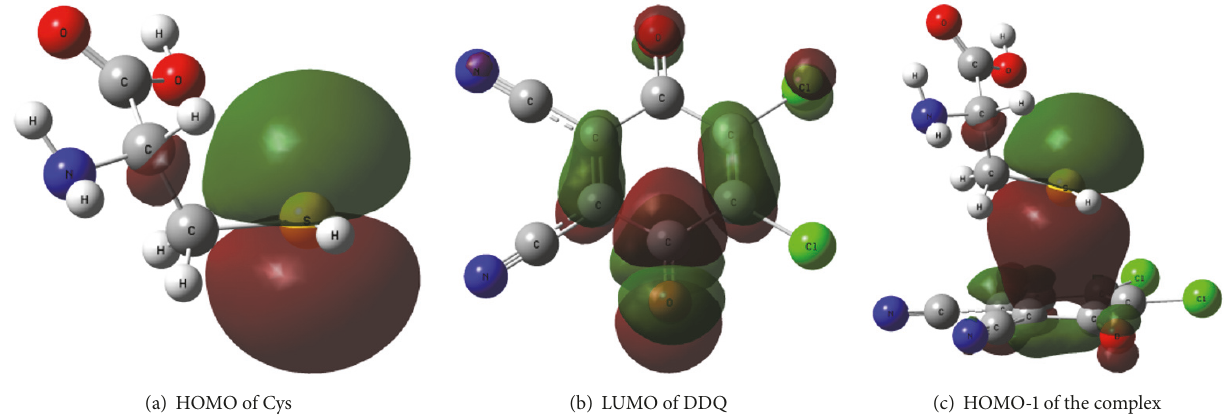
Figure 6: Molecular frontier orbital diagrams of Cys, DDQ, and the